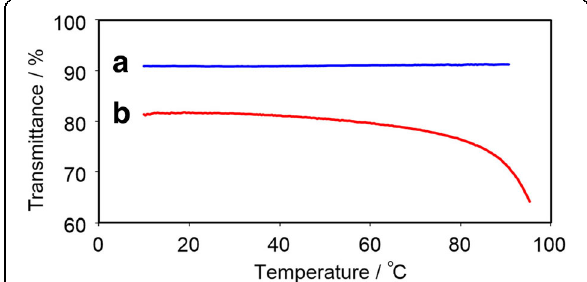
Fig. 3 Temperature dependence of light transmittance of 0.2 wt% aqueous solutions of 1 ( a ) and 2 ( b ) in heating processes